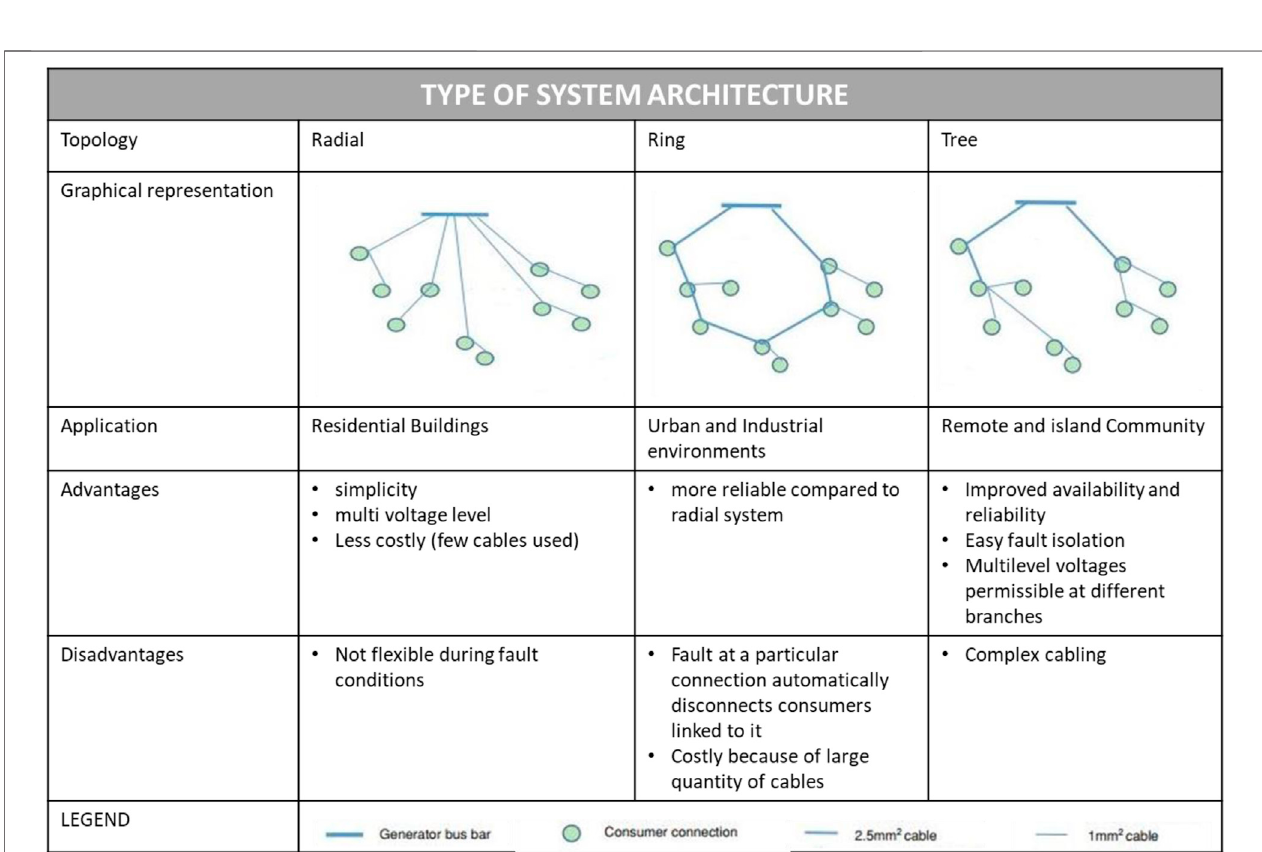
FIGURE 4 | Microgrid topologies applicable to offgrid PV setting Adopted from [29][38][39].